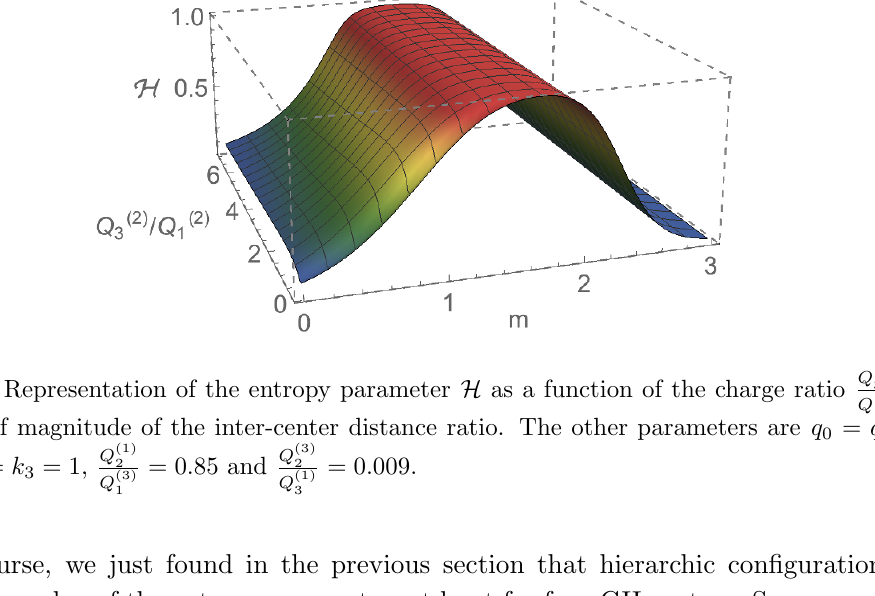
(1) (3) = 0 : 85 and Q = 0 : 2 2 Q (3) 1 Q (1) 3